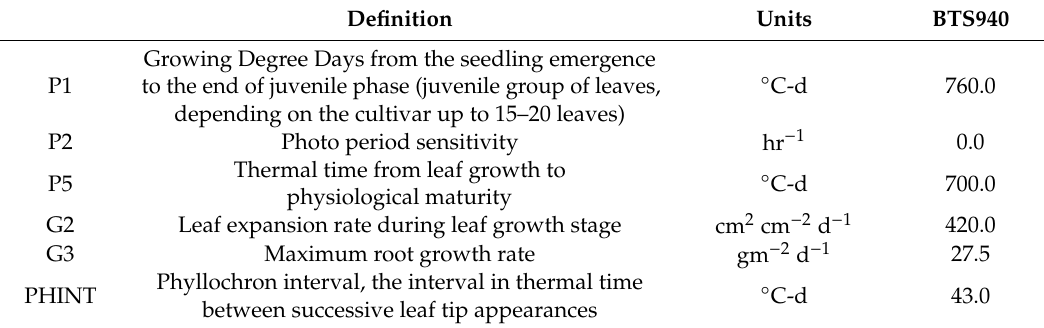
Table 3. Sugar beet cultivar specific genetic coe ffi cients for CSM-CERES-Beet model